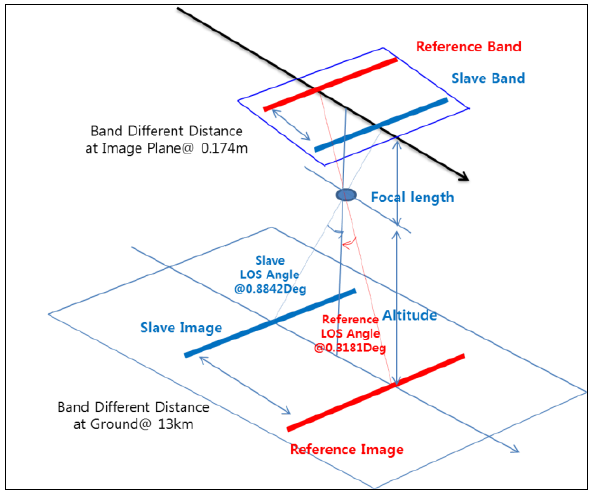
Figure 3. The Band Difference Distance corresponding on the configuration of